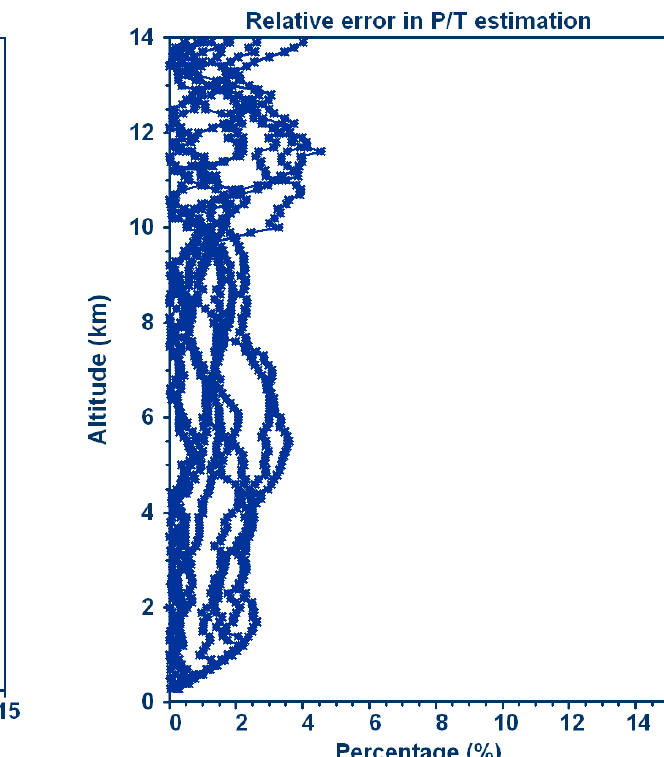
Fig. 5b. Relative error involved by replacing P/T values by P 0 /T 0 exp[-( z − z 0 )/H ] with H equal to 9000m below 9km height with a linear decrease of 1km per 3.5km above this